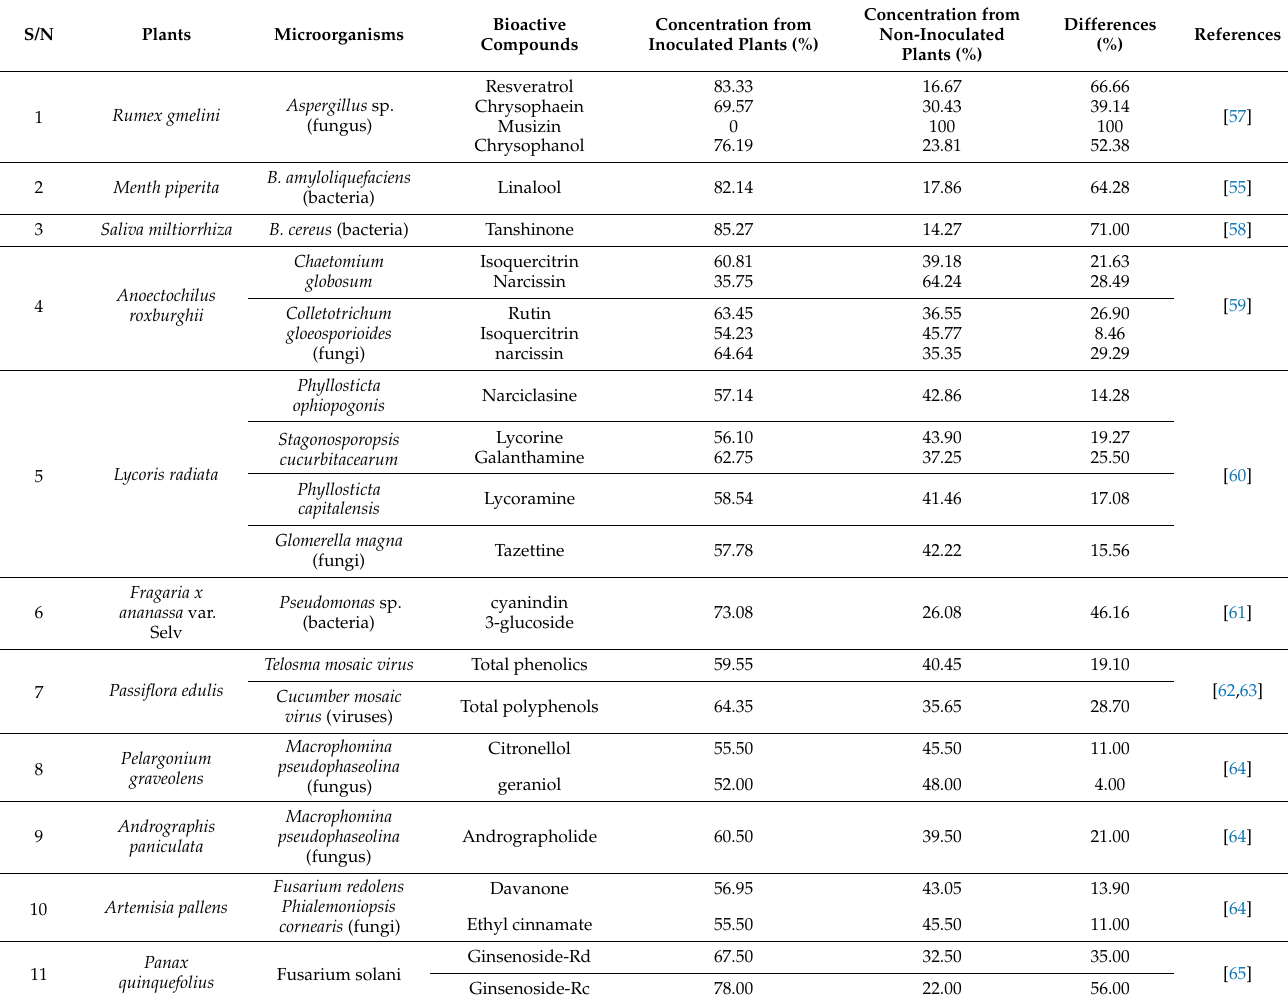
Table 1. Percentage differences in the production of bioactive compounds as affected by microorgan- isms in